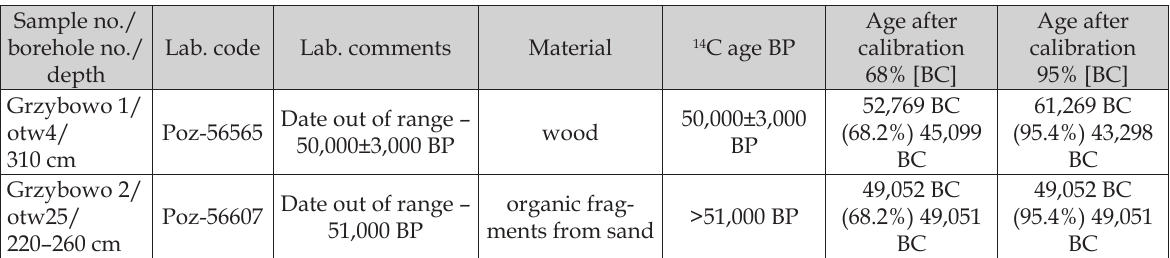
Table 4. calibration of radiocarbon data set; made with oxcal v4.2.4 (Bronk Ramsey 2013) and Intcal13 atmos- pheric curve (Reimer et al.